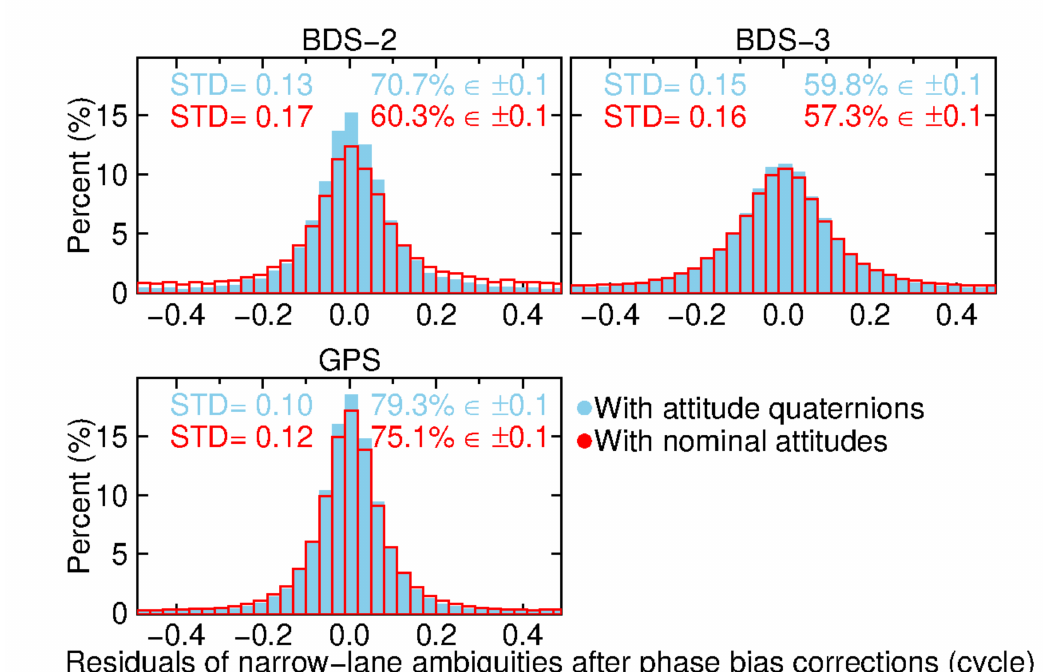
Figure 3. Distribution of GPS, BDS-2 and BDS-3 narrow-lane ambiguity residuals after correcting integer clock products from days 081 to 110 of 2020. The standard deviations of all residuals and the percentages of all within ± 0.1 cycles are plotted at the top left and top right corners of each panel, respectively. The blue bar graphs are residuals after correcting integer clock products including the influence of the attitude quaternions; while the red bar graphs are those without the influence of the attitude quaternions or with the influence of nominal